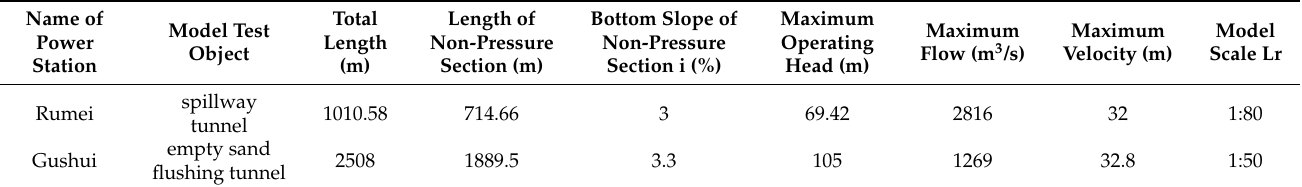
Figure 1. The original aeration type: ( a ) Rumei spillway tunnel; ( b ) Gushui empty sand flushing tunnel. Table 1. Parameters related to model